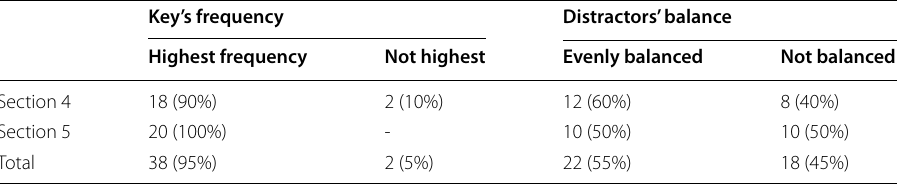
Table 6 The extent to which the multiple-choice distractors and answer keys meet the specified item statistics